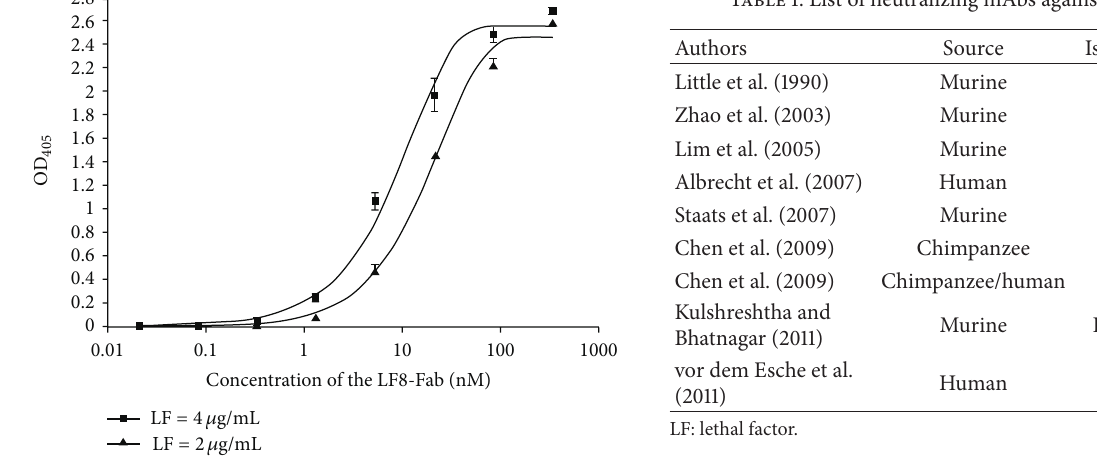
Figure 4: Affinity calculation of the LF8-Fab. Affinity was measured by noncompetitive ELISA. The concentration of the LF8-Fab and the absorbance at 405 nm were plotted to two hyperbolic curves using GraphPad Prism software. The LF8-Fab could identify LF in a dose-dependentmannerwithanaffinityconstantof3.46 × 10 7 L/mol according to the calculation of SPSS statistical software.